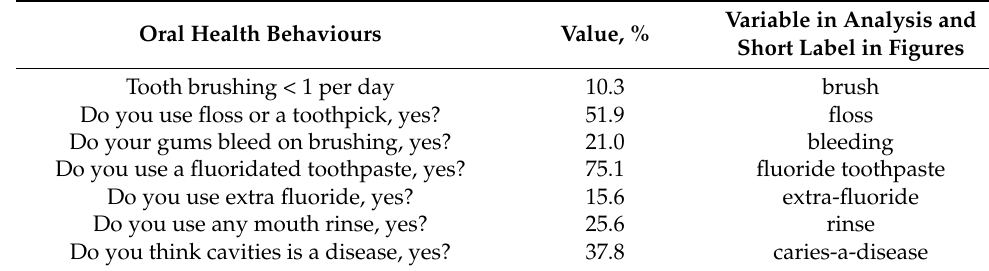
Table 2. Oral health behaviour-related characteristics of the participants in the study